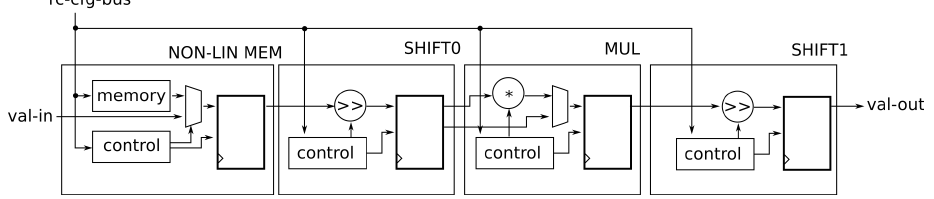
Figure 7. The RC-LANE